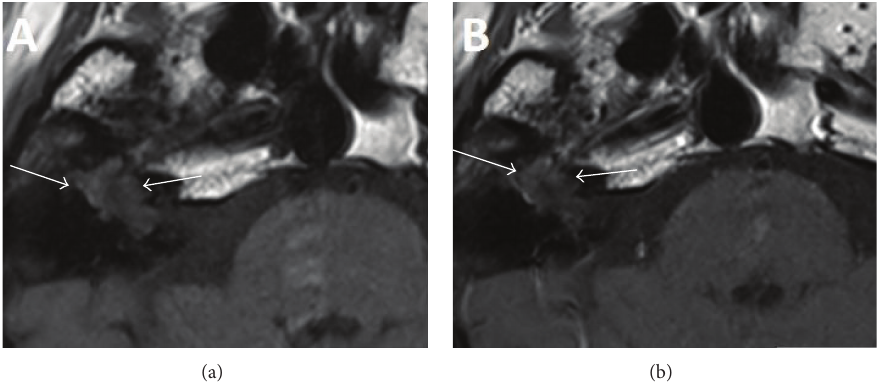
Figure 2: Pre- (a) and postcontrast (b) T1 weighted axial MRI imaging showing a largely isointense signal abnormality at the site of the mass seen on CT. There is no significant enhancement ( white arrows